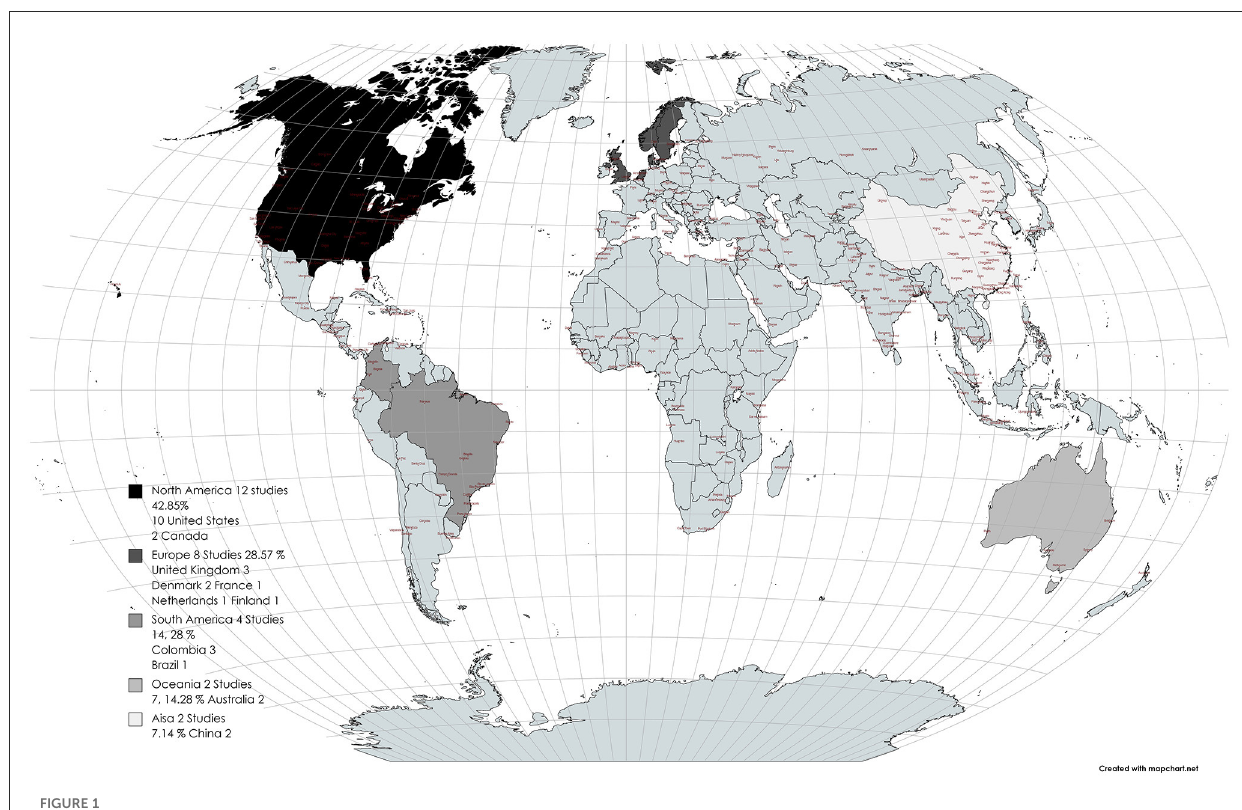
FIGURE1 Study distribution around the